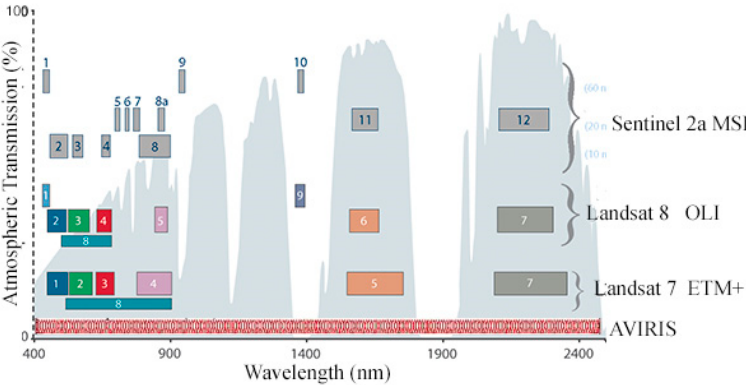
Figure 3. Spectral band comparison for Landsat 7/8, Sentinel 2, and AVIRIS. The AVIRIS hyperspectral sensor has 224 bands with 10 nm FWHM in the 365 to 2500 nm range. Spatial resolution of the AVIRIS IFOV depends on flight altitude. Modified from https://landsat.gsfc.nasa.gov.